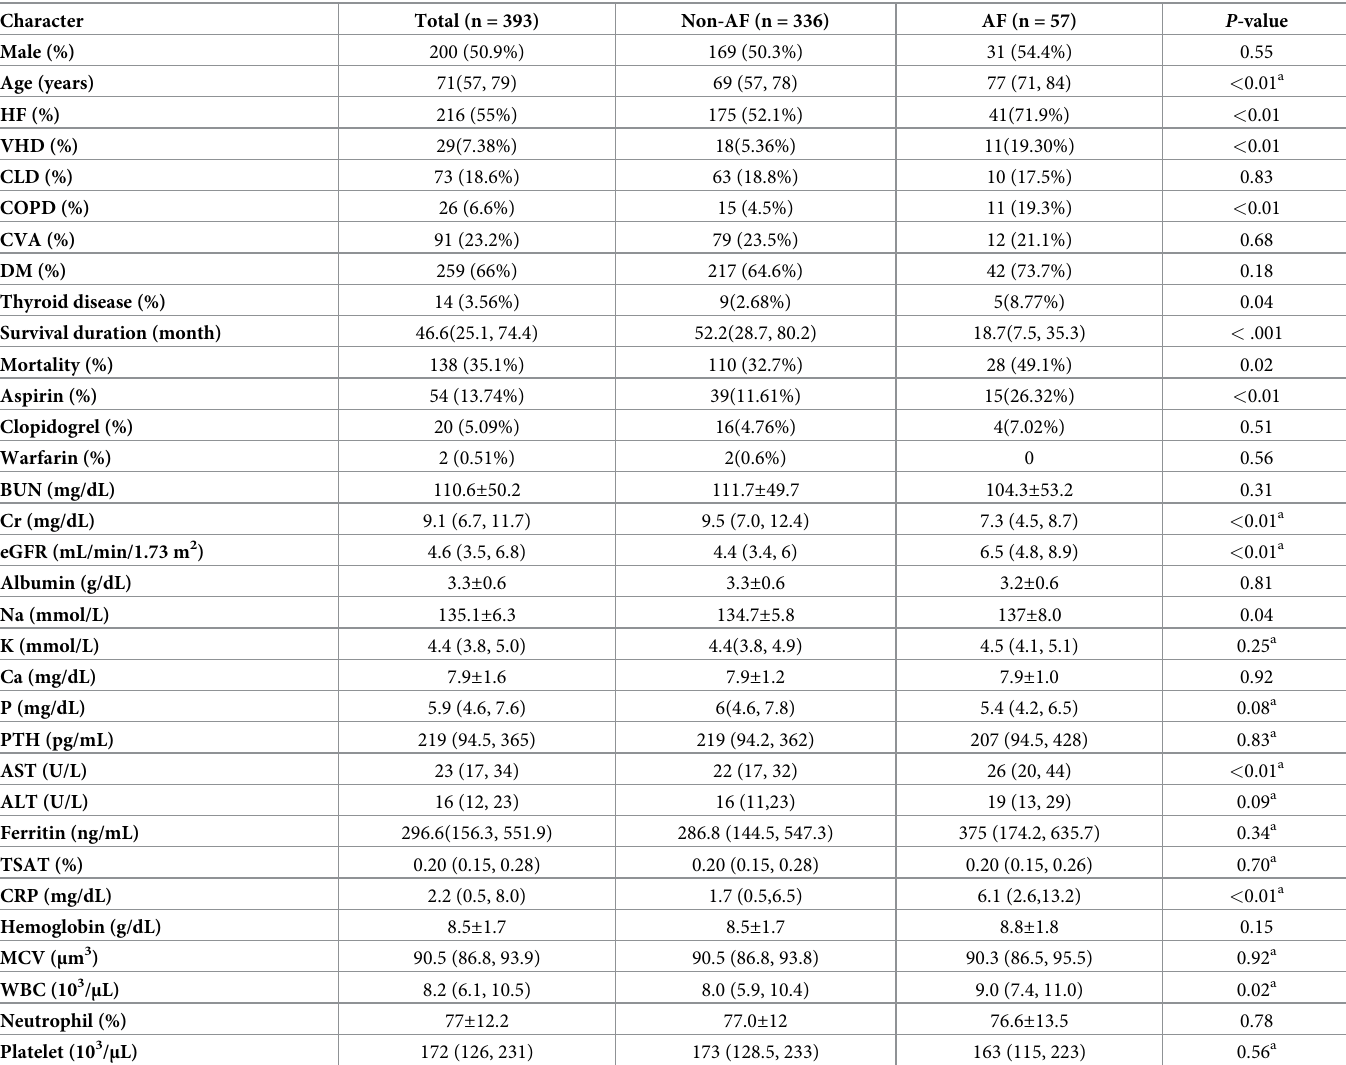
Table 1. Baseline demographic and laboratory characteristics of the study